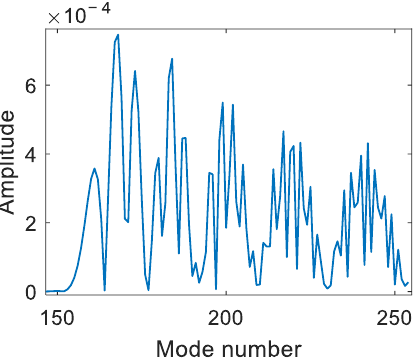
Figure 7. Mode amplitudes for refracted and surface-reflected modes considering ellipsoidal Gaussian eddy case.